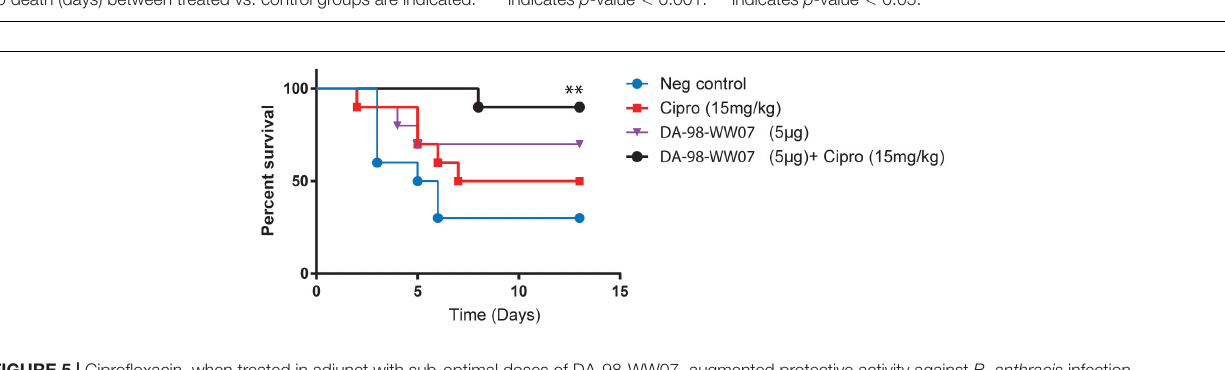
FIGURE 5 | Ciprofloxacin, when treated in adjunct with sub-optimal doses of DA-98-WW07, augmented protective activity against B. anthracis infection. Kaplan-Meier curves of C57BL/6 infected with B. anthracis . Mice were treated with indicated TLR agonists 2 and 24 h prior to infection and 24 or 48 h post infection. Concomitantly, mice were not treated or treated with ciprofloxacin 24, 48, 72, and 96 h post infection. Statistically significant differences (Log- rank test) in time to death (days) between treated vs. control group are indicated. ∗∗ indicates p -value <